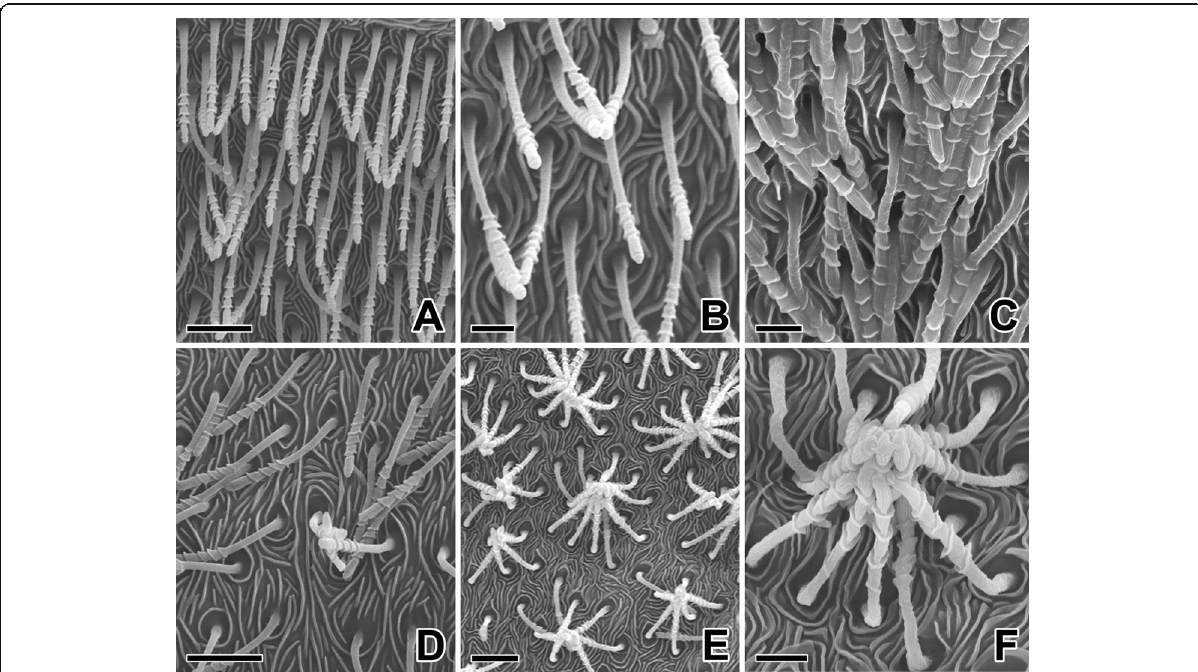
Fig. 4 Scanning electron micrographs of the cribellate spigots in N. albofasciata . a-c The cribellate spigots appeared as singular, long shafts with pagoda-like tiered tips. d-f All spigots are all approximately the same length (10 μ m). These segmented and flexible structure enable to bent itself and conjoin together with adjacent other spigots. Scale bars indicate 5 μ m ( a, d, e ) and 2 μ m ( b, c, f )